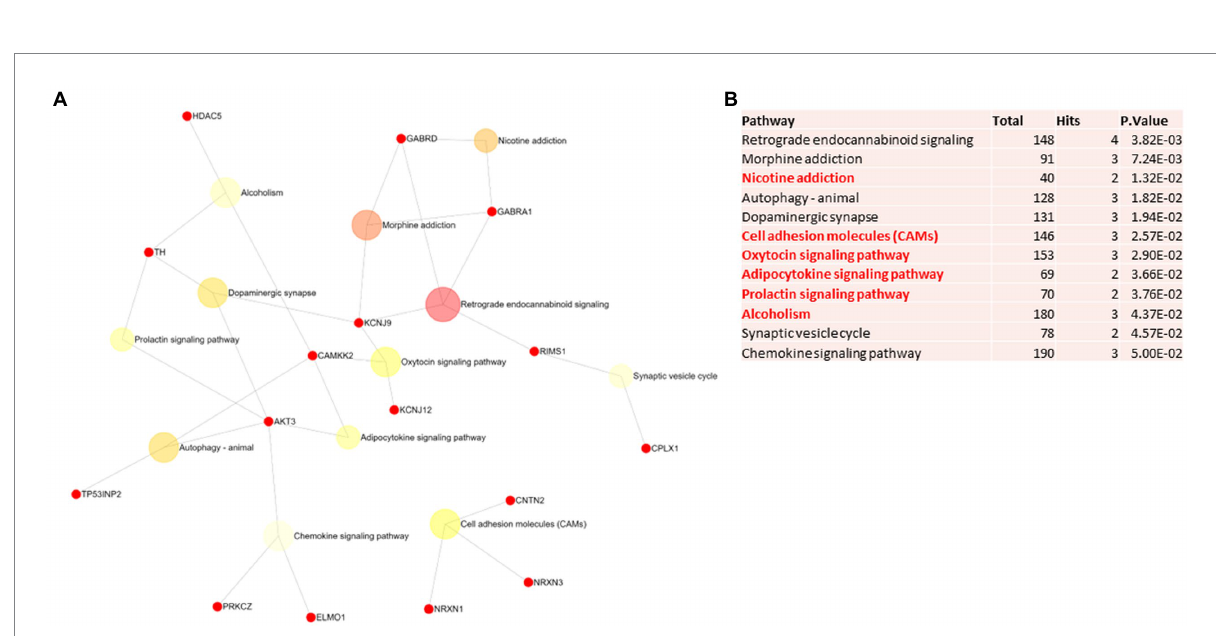
FIGURE 5 Pathway analysis of switch genes from males with Alzheimer’s disease (M-AD). (A) Biological and functional analysis of switch genes from M-AD compared to controls was performed in NetworkAnalyst. Switch genes are depicted in red. (B) The pathways are ranked according to the number of hits and lowest value of p. Pathways are derived from the KEGG database. The unique pathways are shown in